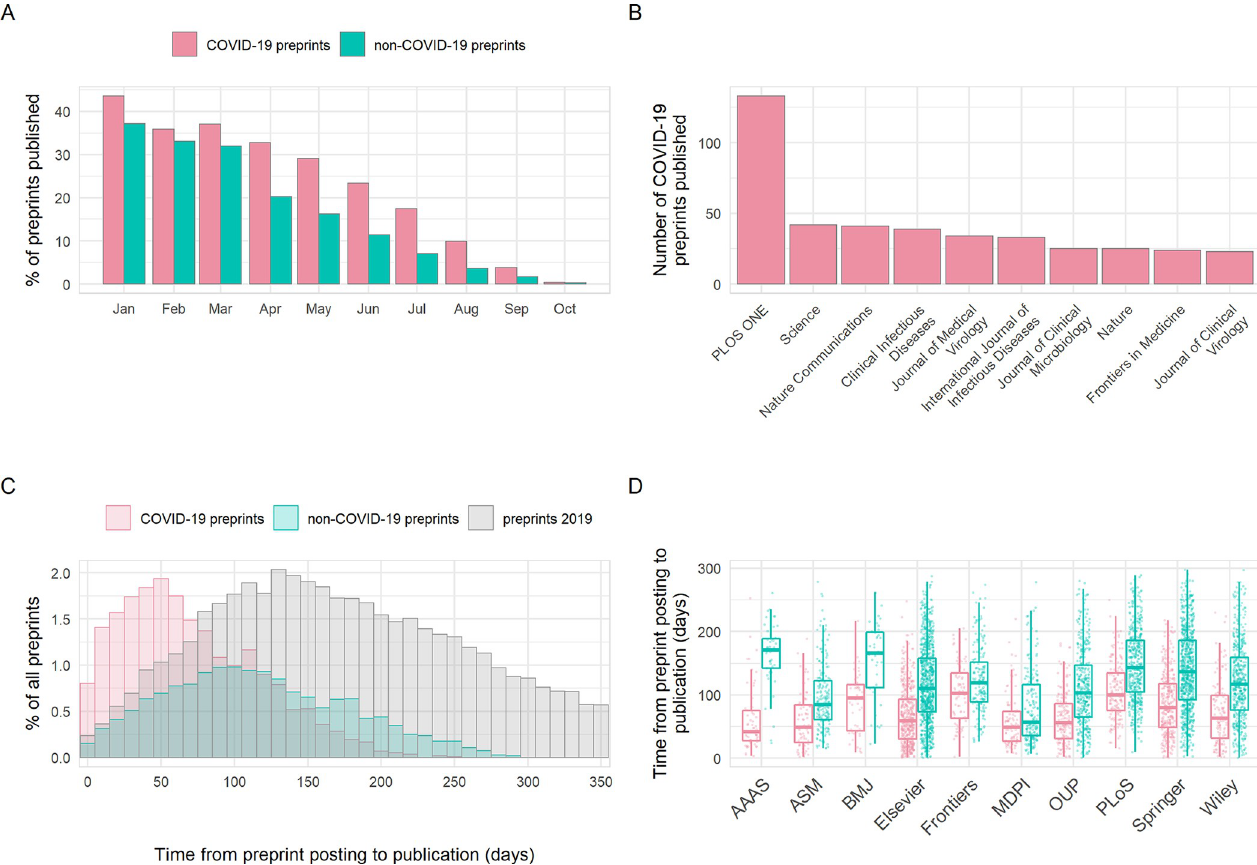
Fig 4. Publication outcomes of COVID-19 and non-COVID-19 preprints deposited on bioRxiv and medRxiv between January 1 and October 31, 2020. (A) Percentage of COVID-19 versus non-COVID-19 preprints published in peer-reviewed journals, by preprint posting month. (B) Destination journals for COVID-19 preprints that were published within our analysis period. Shown are the top 10 journals by publication volume. (C) Distribution of the number of days between posting a preprint and subsequent journal publication for COVID-19 preprints (red), non-COVID-19 preprints posted during the same period (January to October 2020) (green), and non-COVID-19 preprints posted between January and December 2019 (grey). (D) Time from posting on bioRxiv or medRxiv to publication categorised by publisher. Shown are the top 10 publishers by publication volume. Boxplot horizontal lines denote lower quartile, median, upper quartile, with whiskers extending to 1.5 � IQR. All boxplots additionally show raw data values for individual preprints with added horizontal jitter for visibility. The data underlying this figure may be found in https://github.com/preprinting-a-pandemic/pandemic_preprints and